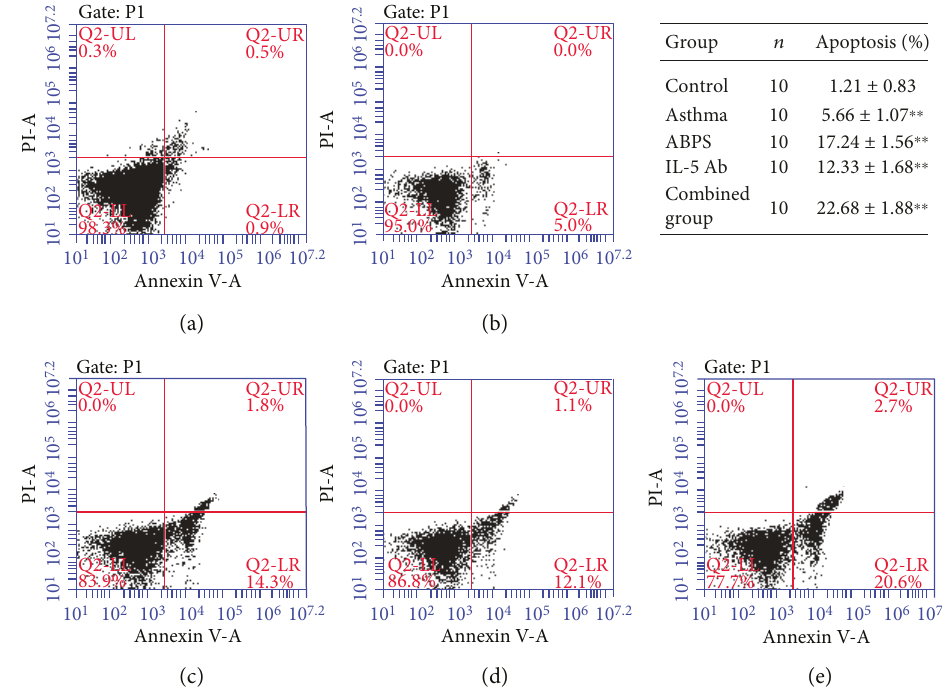
Figure 6: E ff ect of combined treatment on apoptosis proportion of EOS in BALF by AnnexinV-PI. Proportions of di ff erent apoptosis stage presented as above. (a, b, c, d, e) represents control, asthma group, ABPS group, anti-IL-5 and anti-IL-5 mAb, and ABPS combined group, separatively. ∗∗ P < 0 01 , compared to the control group. The signi fi cance of the data was evaluated by one-way ANOVA with Bonferroni ’ s multiple comparison test compared to